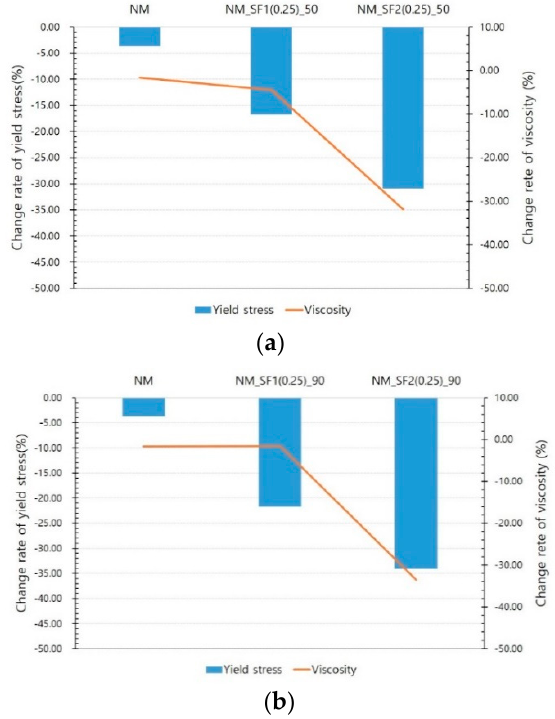
Figure 10. Effect of steel fiber type: ( a ) at 50 V, ( b ) at 90 V.